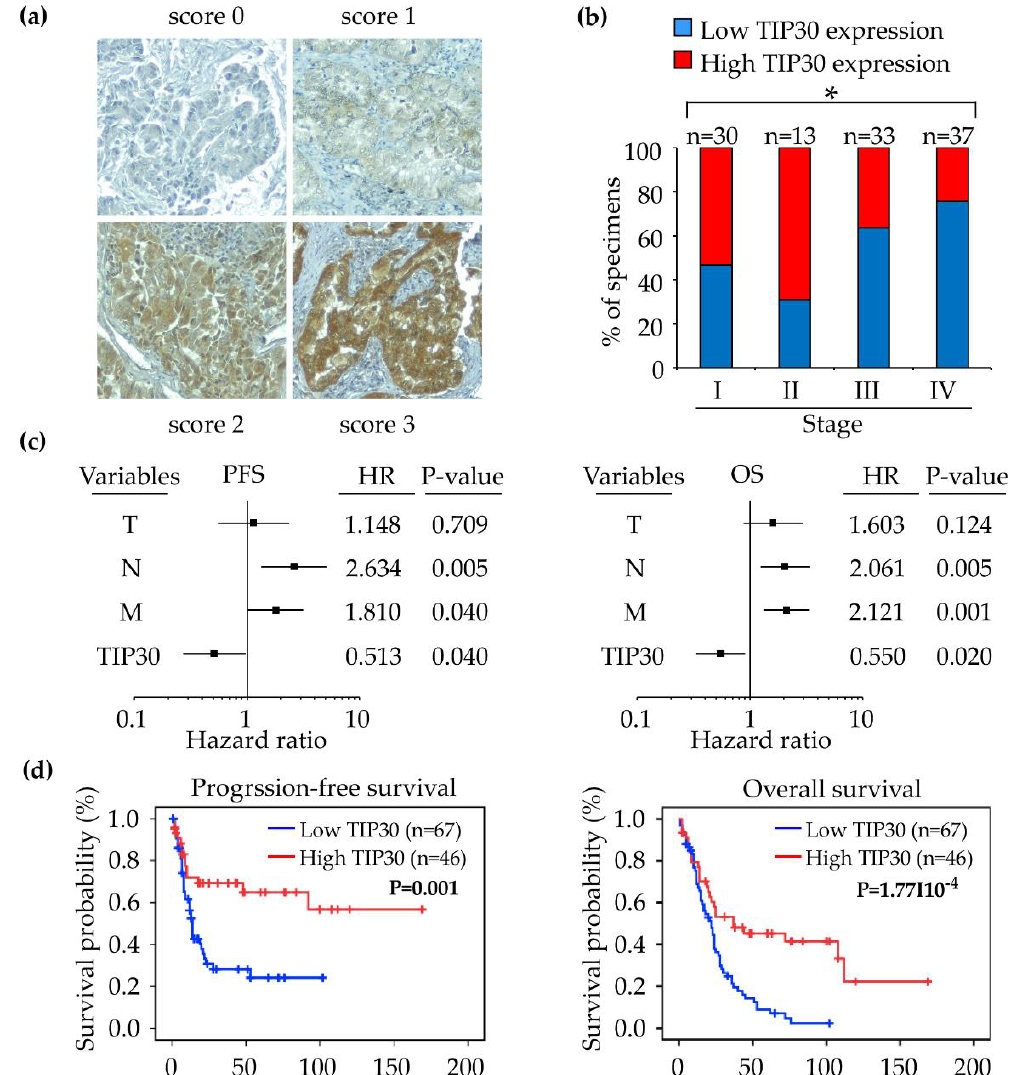
Figure 3. ( a ) The representative immunohistochemistry (IHC) images show the scoring of TIP30 expression from 0 to 3. ( b ) Quantification of TIP30 expression in the specimens from 113 NSCLC patients at different stages. * P < 0.05. ( c ) Forest plots from the multivariate Cox regression models of progression-free survival (PFS; left panel) and overall survival (OS; right panel). ( d ) Kaplan–Meier plots of the progression-free survival (left panel) and overall survival (right panel) of the 113 NSCLC patients, stratified by TIP30 levels.